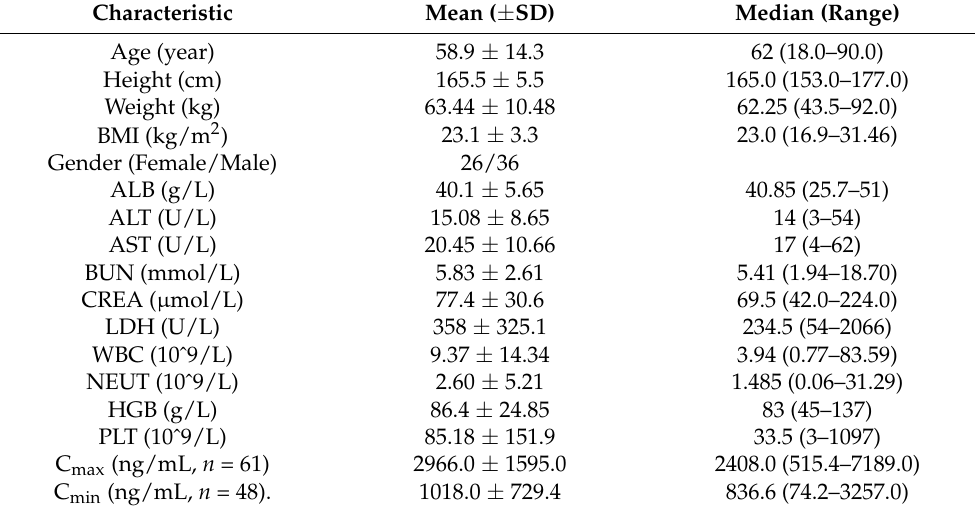
Table 5. Patients’ demographic data and clinical characteristics. ( n =